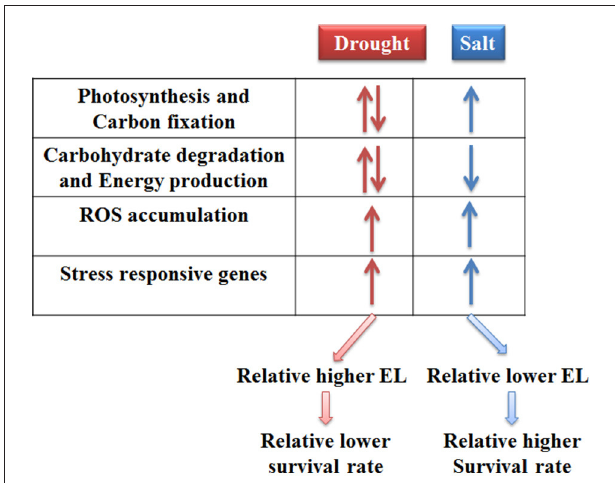
FIGURE 7 | A proposed model for drought and salt stress responses in